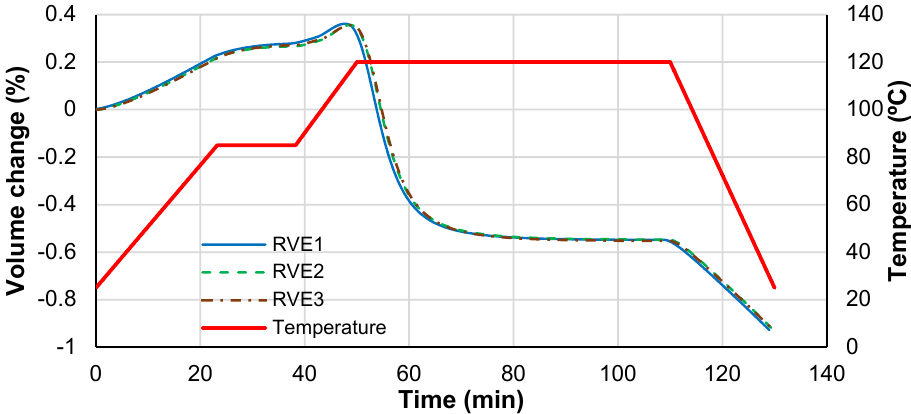
Figure 11. RVE volume change during curing process.